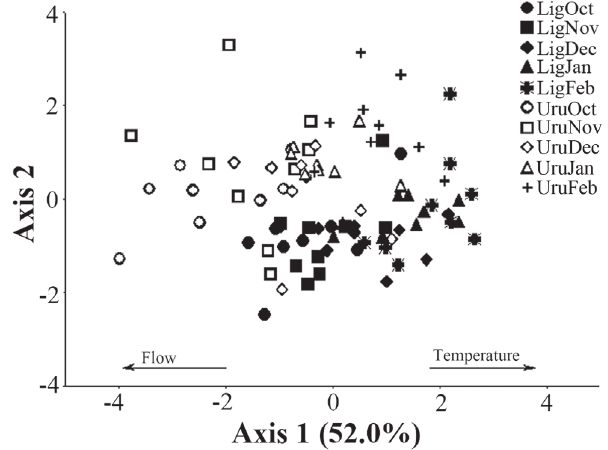
Fig 4. Principal Component Analysis (PCA) of the matrix of environmental variables recorded at the Uruguay and Ligeiro Rivers from October 2001 to February